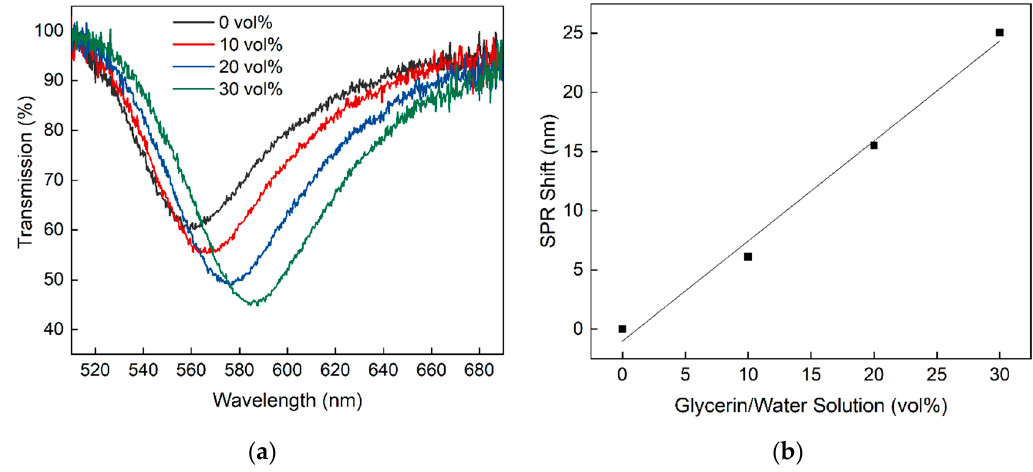
Figure 3. Response of the planar-optical MM SPR waveguide sensor to different glycerin/water solutions. ( a ) The resulting transmission spectrum for different glycerin/water solutions and ( b ) the corresponding SPR wavelength shift for each transmission